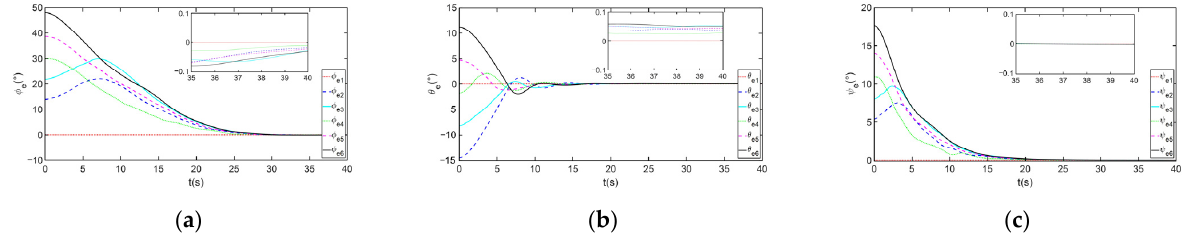
Figure 5. The attitude tracking synchronization error of the swarm utilizing LP systems: ( a ) Roll error; ( b ) Pitch error; ( c ) Yaw error.